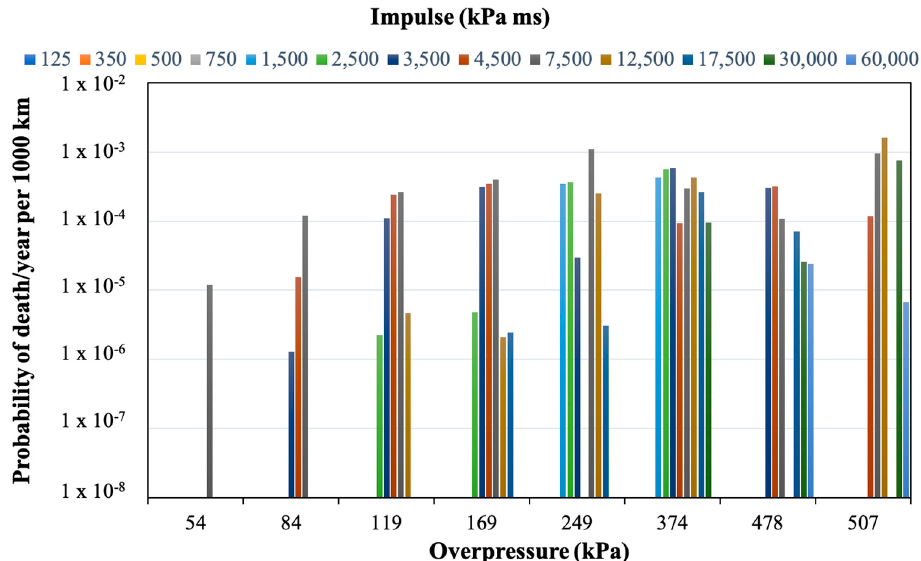
Figure 3. Probability of death from head impact for explosive class 9 and atmospheric stability class F2.